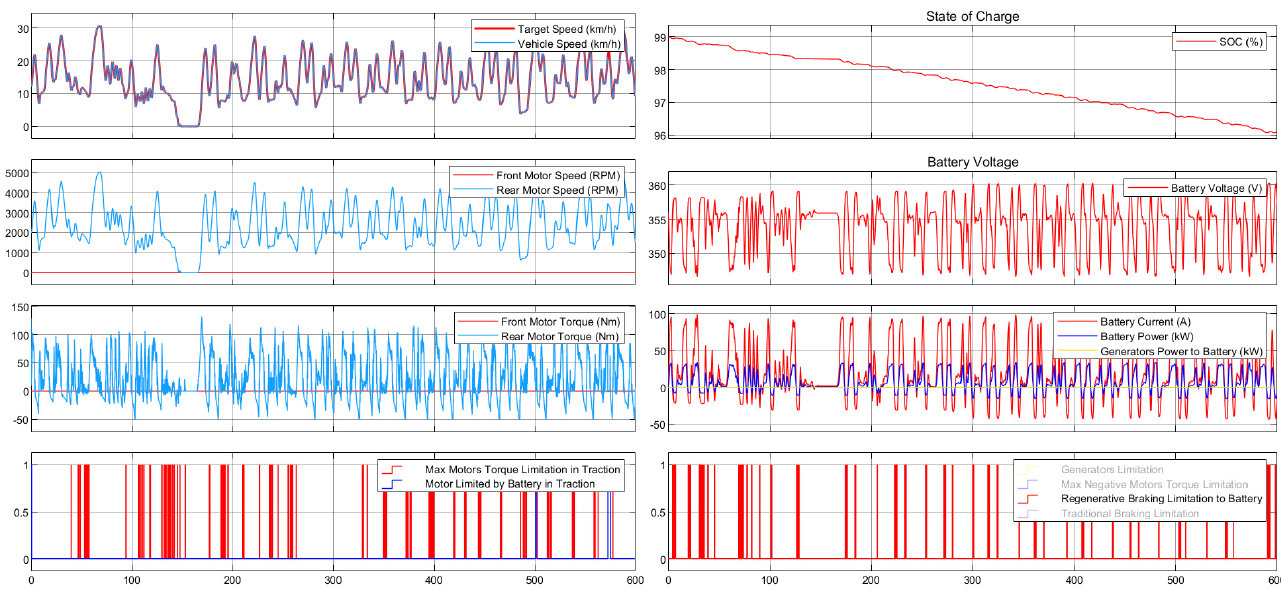
Figure 7. General overview of the results screen, where the abscissa axes show the time expressed in seconds. The units of measure and the parameters of the ordinate axes are shown in the legends. In the two graphs showing the acceleration and deceleration limitations, the value of the limitation is equal to one if this has intervened, 0 vice versa.